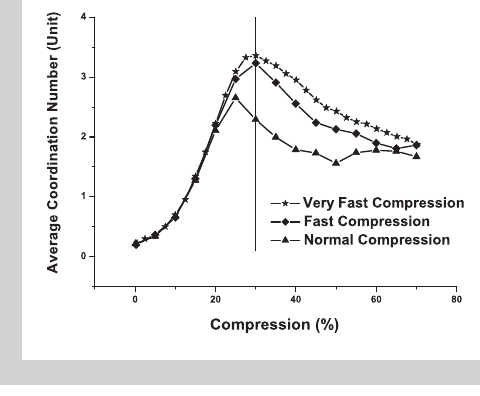
Figure 13: Evolution of the surface area, covered by the parti- cles at the surface, against the percentage area reduc- tion for the three different compression rates: 10 -4 ( ¯ ), 5·10 -5 ( Ï ) and 10 -5 ( Ú ) per simulation unit time. Figure 14: Evolution of the average coordination number against the percentage area reduction for the three dif- ferent compression rates: 10 - 4 ( ¯ ), 5·10 -5 ( Ï ) and 10 -5 ( Ú ) in inverse simulation time unit. Figure 15: Stress in the direction of compression for three differ- ent compression rates: 10 -4 ( ¯ ), 5·10 -5 ( Ï ) and 10 -5 ( Ú ) per simulation unit